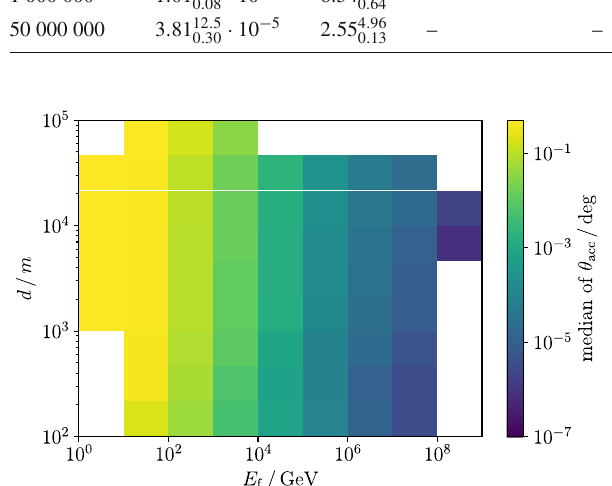
Fig. 6 The median of the accumulated deflection θ acc is presented in degree as a function of the final muon energy E f and the propagation distance d . The result is presented for 50370 muons for a propaga- tion through ice. An energy cut of v cut = 10 − 3 , MSM and the deflec- tion parametrizations of vG are used. The initial energies are not fixed. The muon deflection depends primarily only on the final muon energy. Even the propagation distance is negligible if the initial muon energy is unknown in the multiple scattering, respectively. Since the presented measurements of the muon deflection are based on muon energies lower 10 GeV, deflection measurements of muons with energies up to TeV or even higher are required to vali- date the results at higher energies.